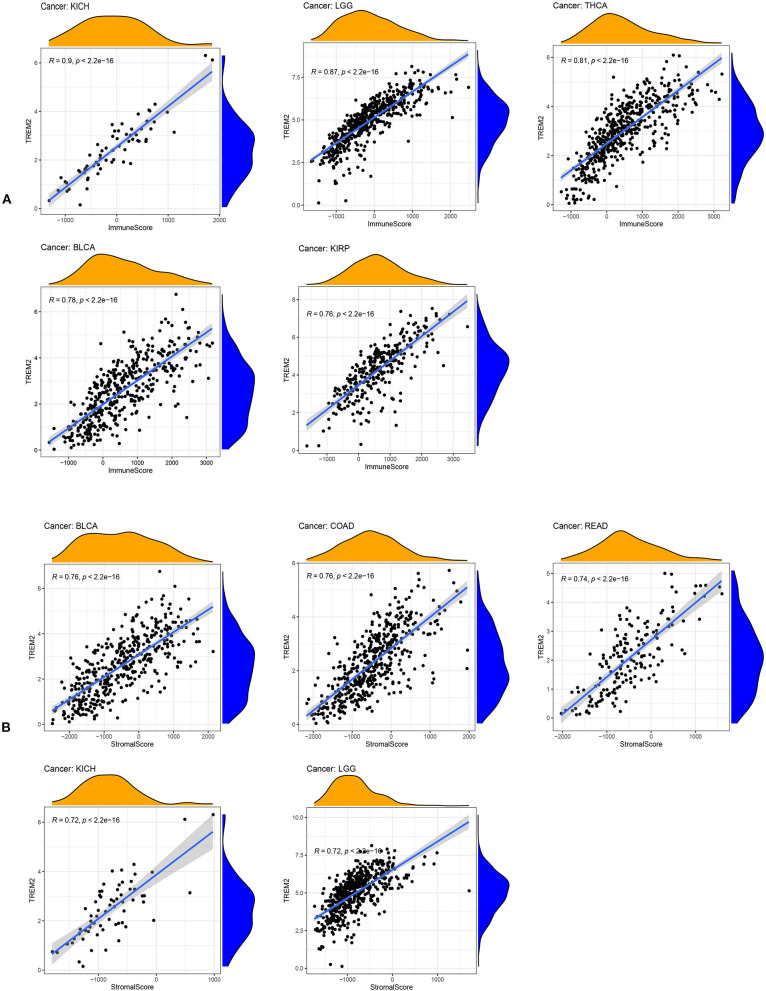
Five tumors with the highest correlation coefficients between TREM2 expression and the tumor microenvironment. (A) Correlation between TREM2 and immune scores in kidney chromophobe (KICH), brain lower grade glioma (LGG), thyroid carcinoma (THCA), bladder urothelial carcinoma (BLCA), and kidney renal papillary cell carcinoma (KIRP). (B) Correlation between TREM2 and stromal scores in BLCA, colon adenocarcinoma (COAD), rectum adenocarcinoma (READ), kidney chromophobe (KICH), and LGG.